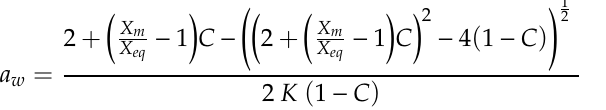
Multivariate analysis between surface and capillarity absorption properties of the studied pulps and their chemical composition and fiber morphology were obtained by principal component analysis, while using JMP14 software